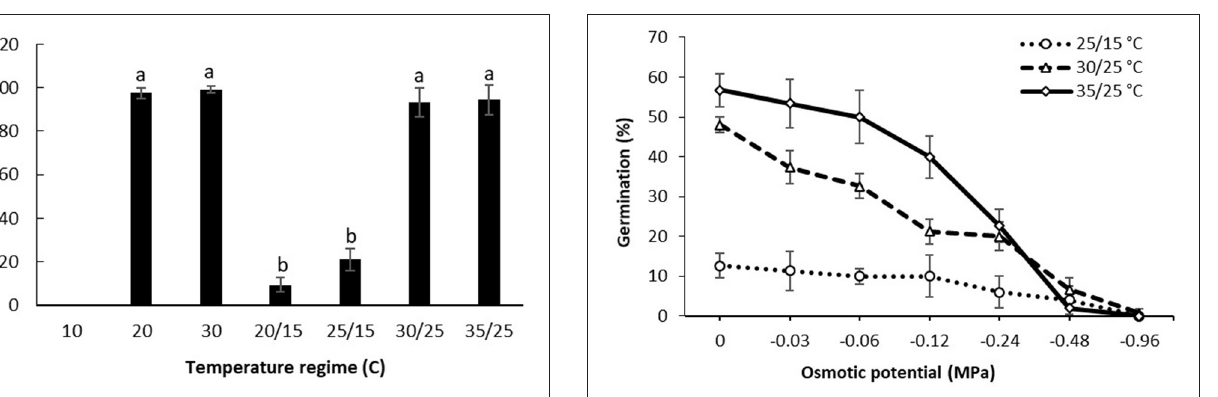
FIGURE 3 | Effect of osmotic potential on germination of P. capillare seeds incubated at alternating temperature regimes with a 12-h photoperiod. Vertical bars represent the standard error of the mean.